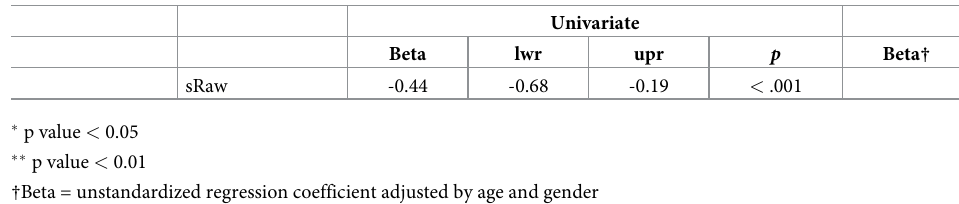
value, and AUC for the cutoff values of the LDIs and PFT parameters are presented in Table 4. The parameters with high AUC for BO diagnosis were FEF25–75% (cutoff, 56.0%; AUC = 0.961), FEV1 (cutoff, 81%; AUC = 0.931), FEV1/FVC (cutoff, 80%; AUC = 0.897) in the conventional PFTs. In the LDIs, E900 (cutoff, 1.4%; AUC = 0.920), E950 (cutoff, 0.1%; AUC = 0.919), E850 (cutoff, 4.6%; AUC = 0.913), E/I MLD (cutoff, 86.9%; AUC = 0.887), and MLDD (109 HU; AUC = 0.867) were parameters with high AUC.